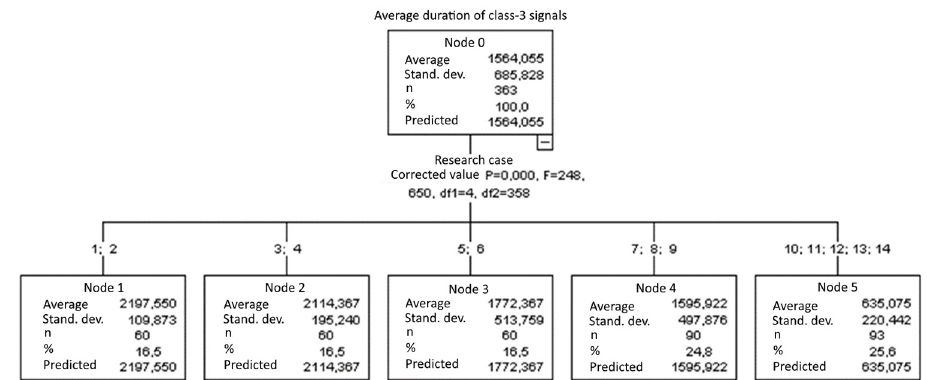
Figure 24. Classification tree for the average duration of class-3 signals.